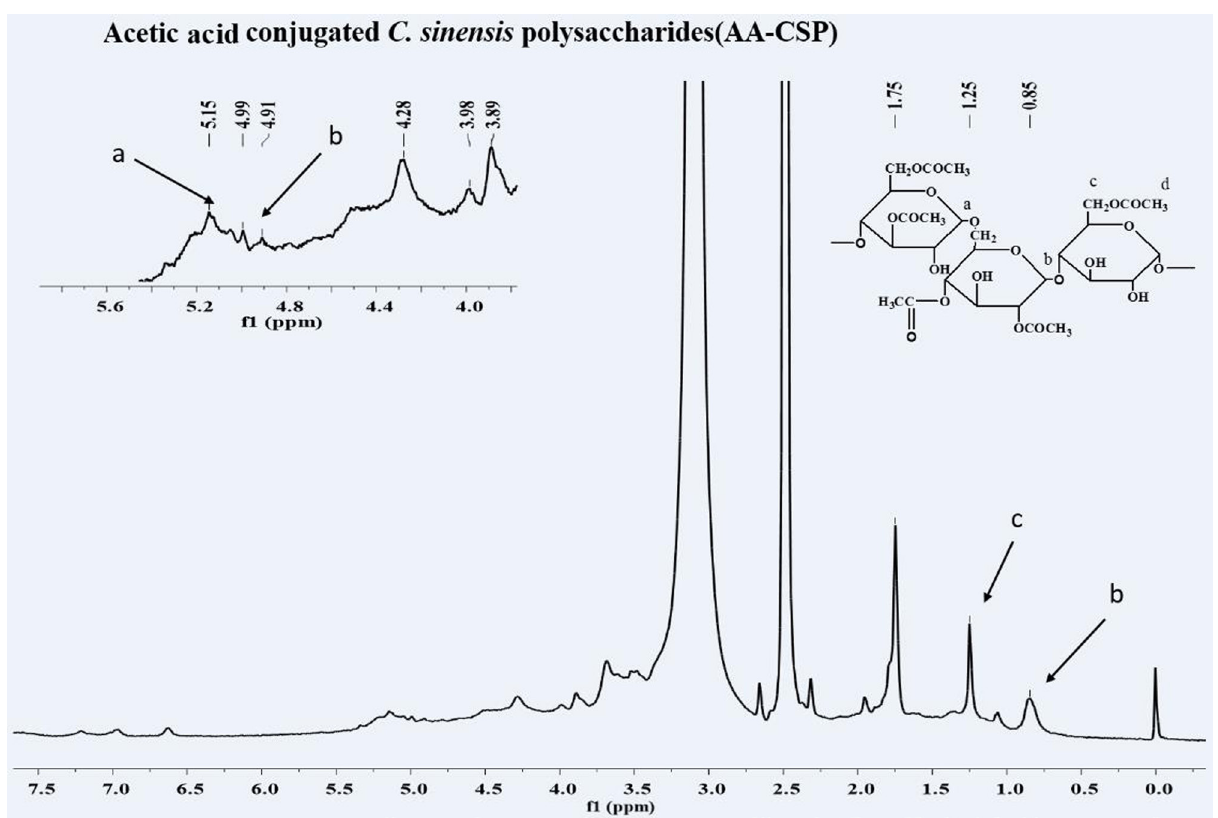
. 1 H-NMR spectra indicated the generation d6